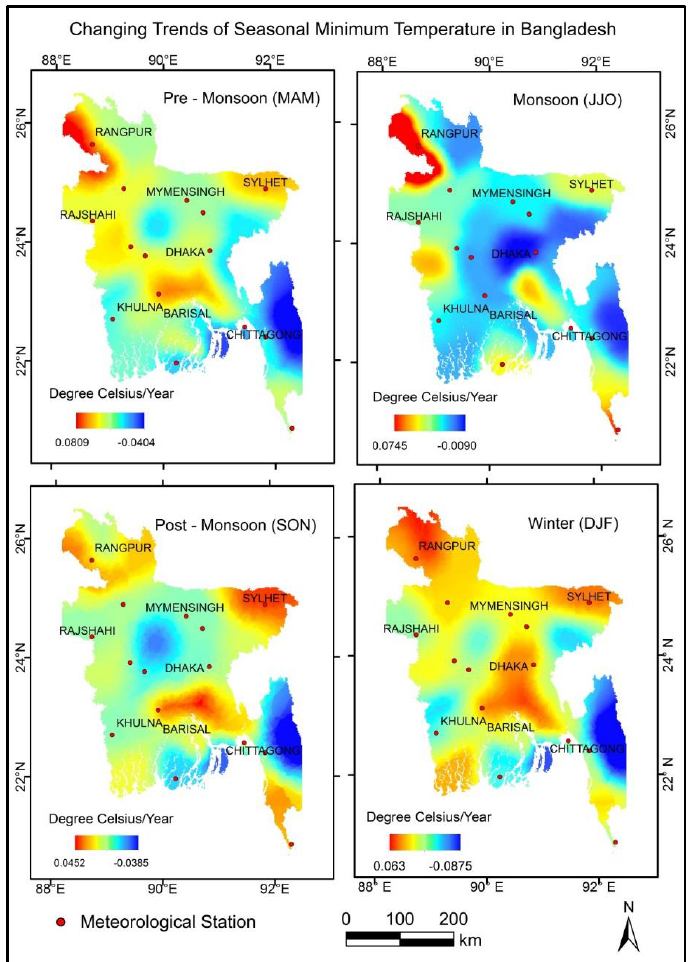
Figure 5. Geospatial distribution changing tends at seasonal average minimum temperature.